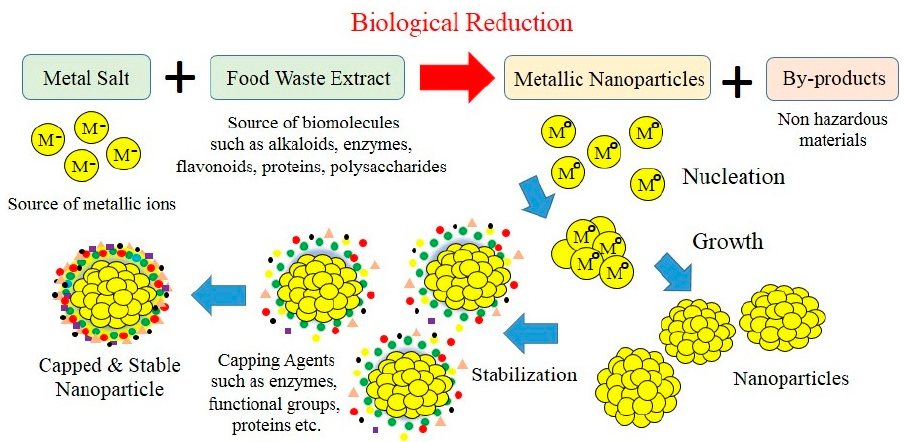
Figure 3. Schematic diagram of the mechanism behind the biogenic synthesis of metallic nanoparticles.